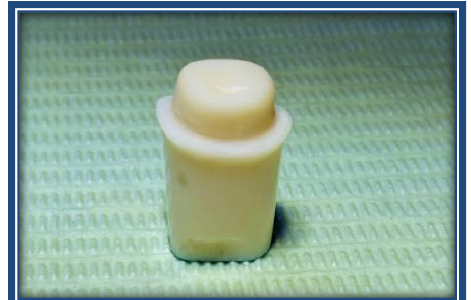
Figure 1: A dentoform tooth prepared with deep chamfer finish line